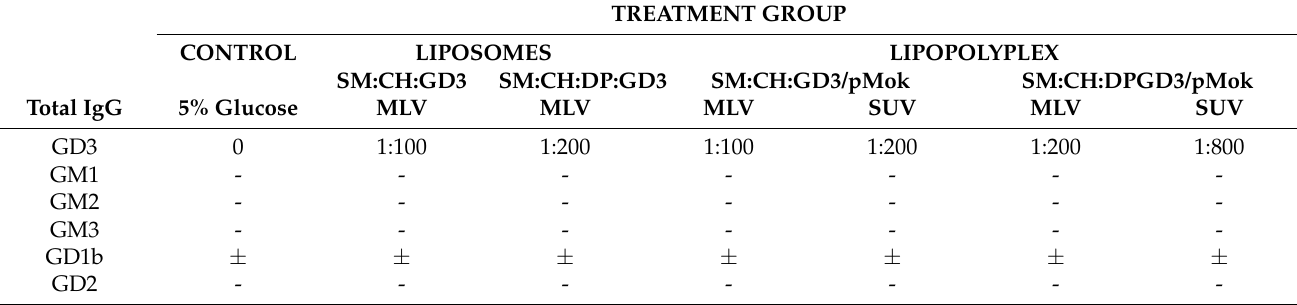
Table 5. Specificity of the anti-GD3 immune response in mouse plasma after the third dose of vaccine. Cross-reactivity against other gangliosides with a chemical structure similar to GD3 (GM1, GM2, GM3, GD1b, and GD2) was measured by ELISA in the samples obtained after the third vaccination dose. Plasma samples only exhibited slight reactivity against the GD1b antigen, while the cross-reactivity was negligible for the rest of the antigens. The titers correspond with the maximal dilution of mice serum that yielded an optical density above 0.100. These determinations were performed in triplicate and only results with dispersion lower than 5% were accepted. The symbol ± was employed to indicate that although the optical density average result of three replicates was below 0.100, the data of one out of three replicates resulted slightly higher than